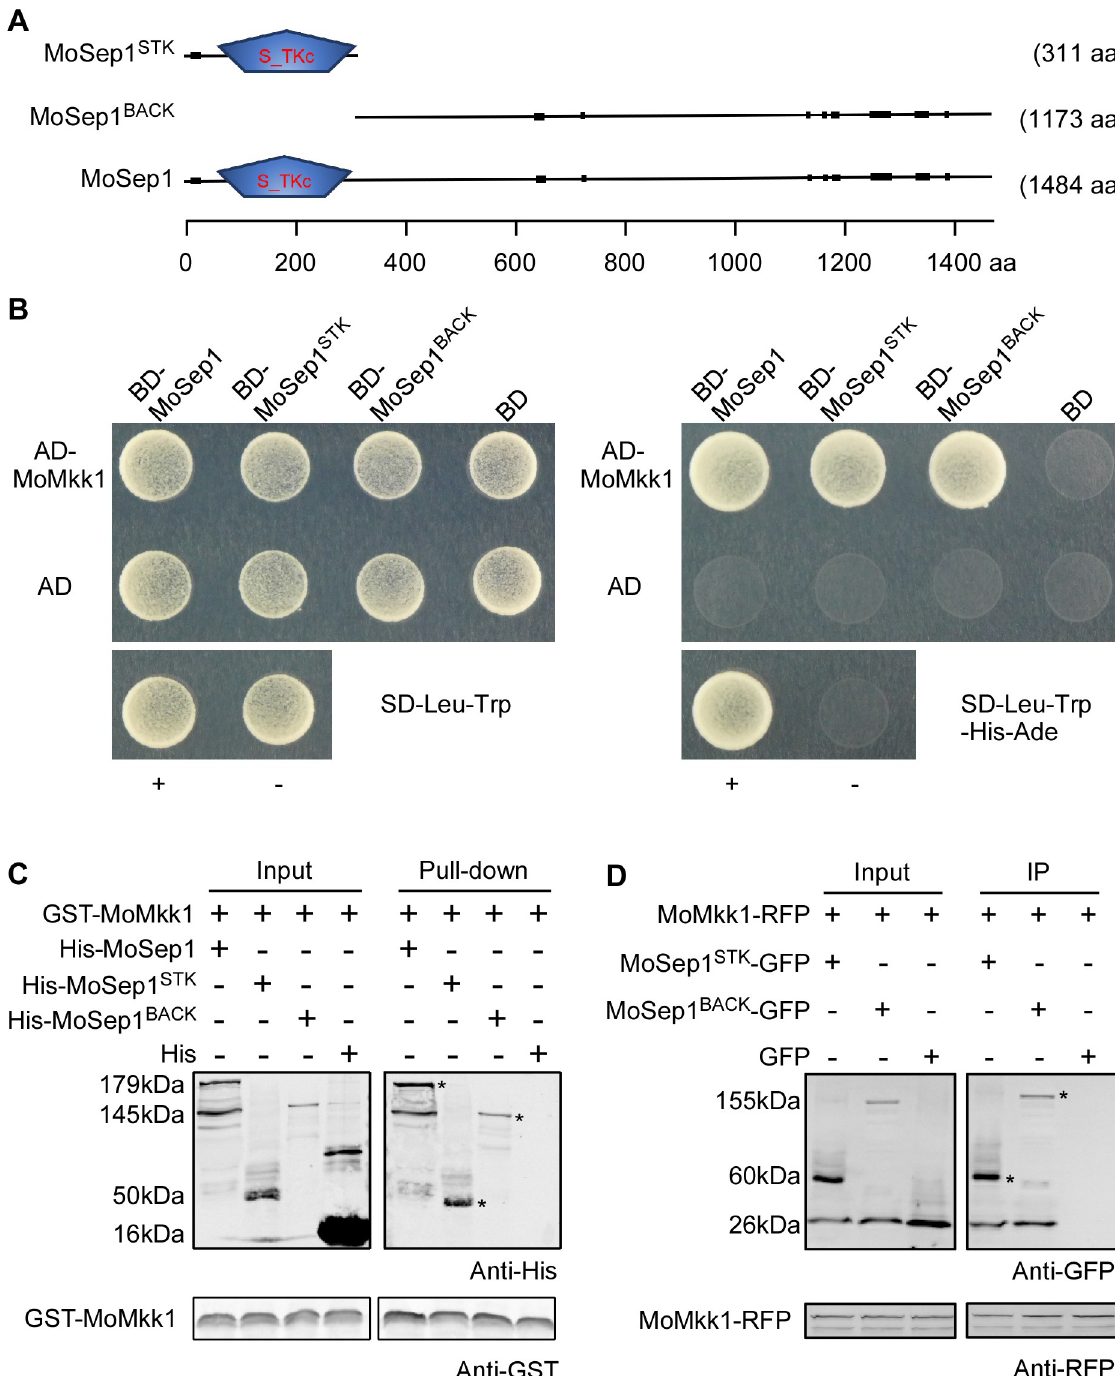
Fig 2. The Mitosis Exit Network (MEN) kinase MoSep1 interacts with MoMkk1. (A) Schematic representation of MoSep1 and its two segments MoSep1 STK and MoSep1 BACK . S_TKc domain was predicted using the SMART program (http//smart.embl-heidelberg.de/). aa, amino acid. (B) Yeast two-hybrid analysis of the interaction between MoMkk1 and MoSep1. MoMkk1 was inserted into vector pGADT7, two segments of MoSep1 (MoSep1 STK and MoSep1 BACK ), and MoSep1 full-length were inserted into pGBKT7. AD-MoMkk1 and BD-MoSep1, AD-MoMkk1 and BD-MoSep1 STK , AD-MoMkk1, and BD-MoSep1 BACK were co-introduced into yeast AH109 strain, respectively, and then incubated on SD-Leu-Trp (as control) and SD-Leu-Trp-His-Ade (for selection) for 5 days. (C) In vitro pull-down assay of GST-MoMkk1 and His-MoSep1, His-MoSep1 STK , His- MoSep1 BACK . Recombinant GST-MoMkk1 bound to glutathione Sepharose beads was incubated with the bacterial cell lysate containing His-MoSep1, His-MoSep1 STK , His-MoSep1 BACK , respectively. Eluted protein was